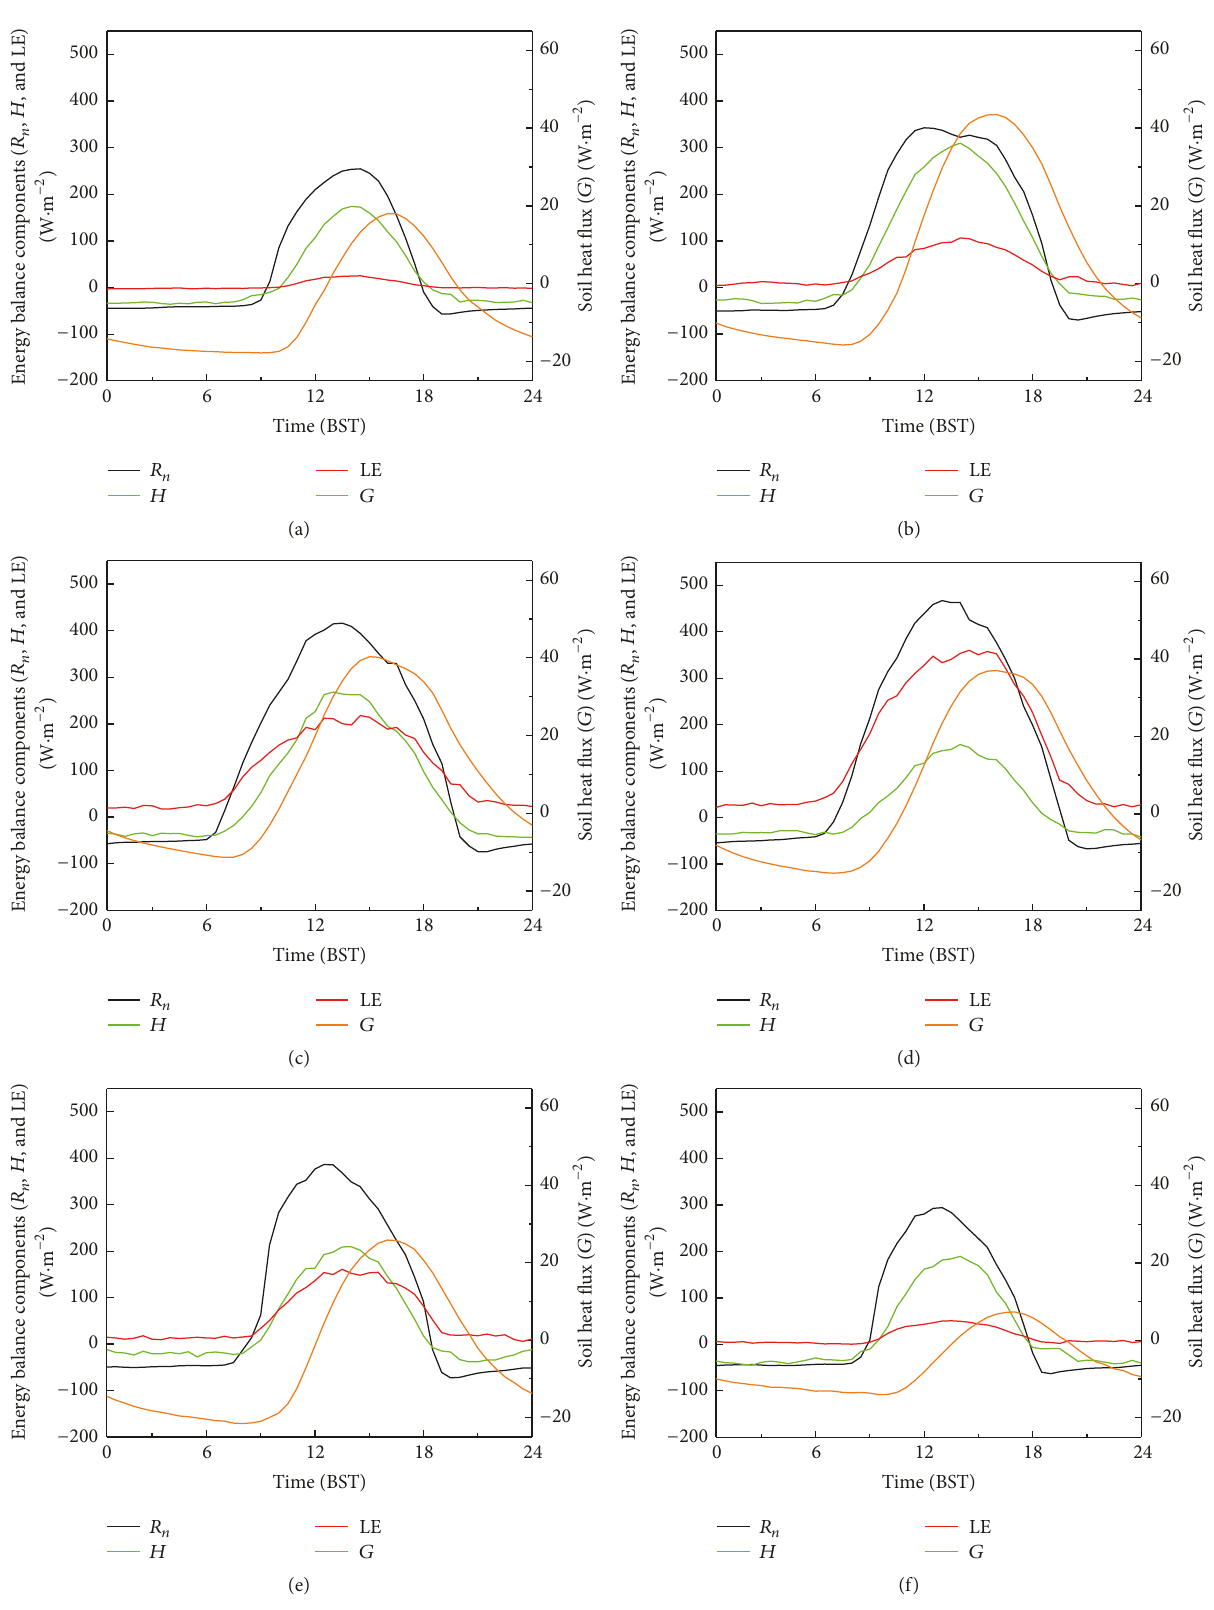
Figure 3: Averaged diurnal variations of net radiation flux ( 𝑅 𝑛 ), latent heat flux (LE), sensible heat flux ( 𝐻 ), and soil heat flux ( 𝐺 ) in the following periods: (a) the soil-frozen period (DOY 326–64); (b) the soil ablation period (DOY 65–130); (c) the germination, flowering, and leaf expansion period (DOY 131–169); (d) the vibrant growing season (DOY 170–253); (e) the leaf senescence period (DOY 254–288); and (f) the early soil-frozen period (DOY